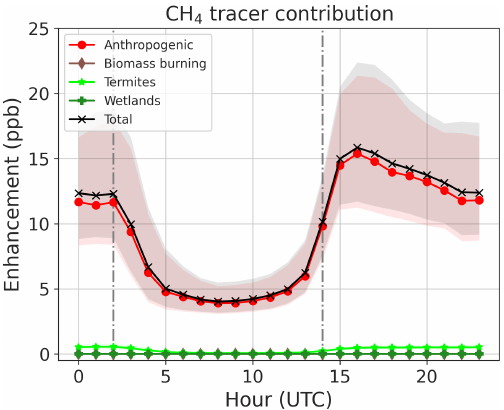
Figure 13. Diurnal cycle of in situ CH 4 tracer contributions of WRF-GHG at SDe. The black crosses represent the median hourly enhancements above the background for the sum of all tracers. The separate tracer contributions are given in red (anthropogenic), dark green (wetlands), light green (termites), or brown (biomass burn- ing). The shaded areas cover the interquartile ranges. The gray dot- ted vertical lines at 02:00 and 14:00UTC indicate the approximate times of sunrise and